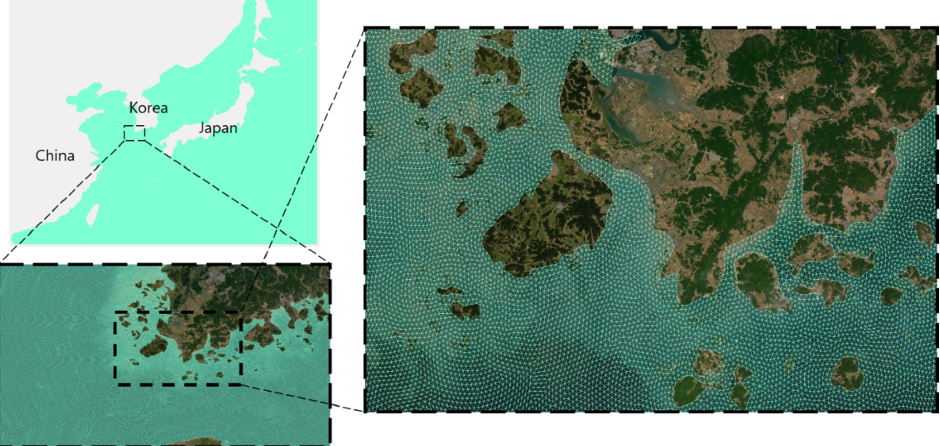
Figure 17. Ultra-high resolution grid for FVCOM-NWP.